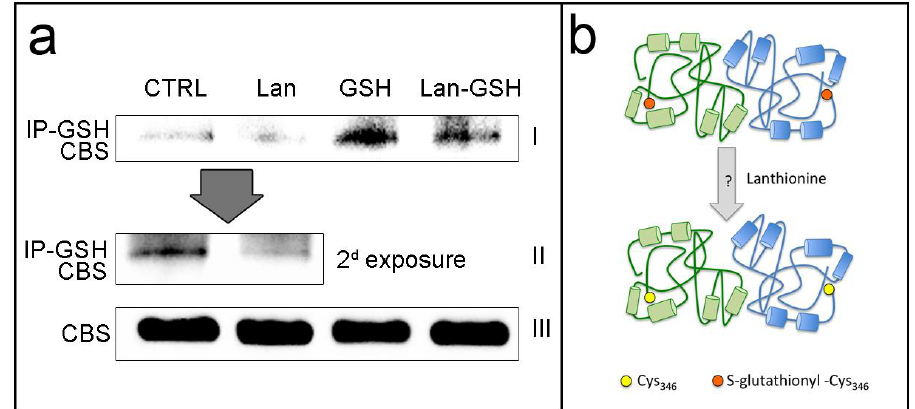
Figure 2. Effect of lanthionine on CBS glutathionylation. ( a ) Endothelial cells were treated with 0.3 μM lanthionine and/or with 1 mM GSH during 24 h. These experiments were accomplished without pre-incubation with the stimulation cocktail, because under stimulating conditions lanthionine significantly reduces the amount of CBS protein, which may interfere with the evaluation of the amount of immunoprecipitated protein. Western blotting shows the analysis of cell protein extracts. First two rows from top (I and II), proteins were immunoprecipitated with anti-GSH antibodies (IP-GSH) and subsequently detected with anti-CBS antibody. Row II: 2nd (prolonged) exposure of the half left part of row I, more clearly showing the difference between lanthionine treated cells and control samples. Row III (CBS); non immunoprecipitated parallel samples treated as in I and II, showing that the initial amounts of CBS was the same in all starting extracts. ( b ) Tentative scheme depicting summarily the possible interpretation of our findings presented in a. According to this model lanthionine lowers CBS activity by hampering CBS activation induced by GSH-dependent glutathionylation. The actual mechanism is not known. Cys, cysteine; CTRL, control; Lan, lanthionine; GSH, glutathione.